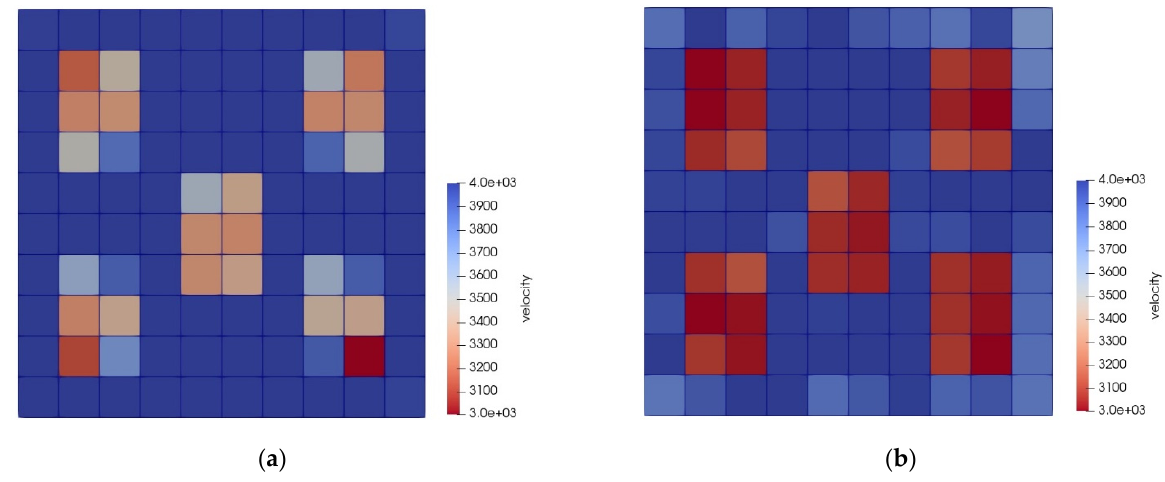
Figure 7. Identified results of the 30% defected area: ( a ) LASSO algorithm; ( b ) SIRT algorithm.